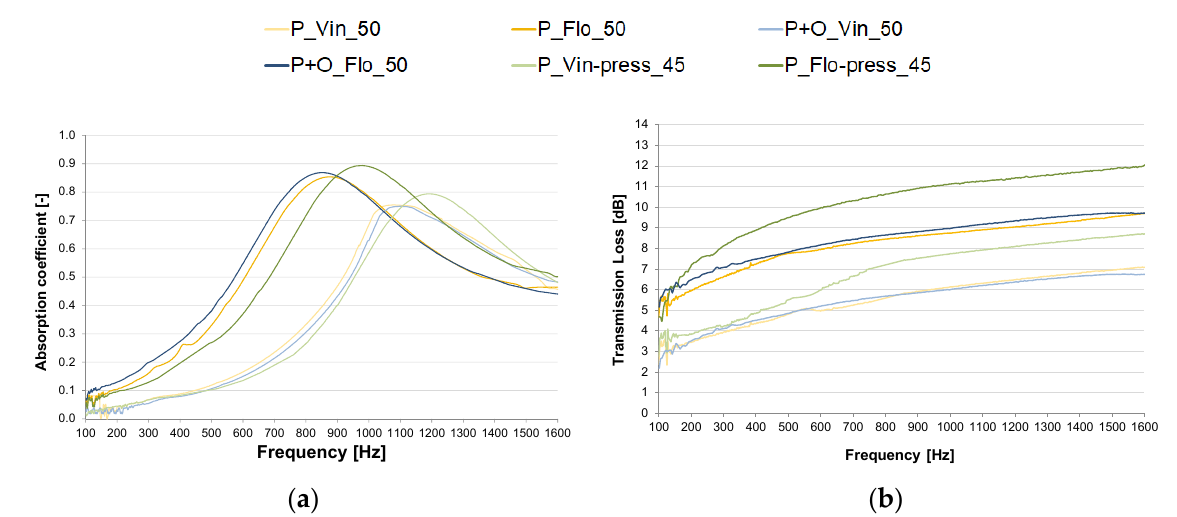
Figure 6. Influence of pressing technique on the acoustic performance of pine panels: ( a ) sound absorption coefficient and ( b ) Transmission loss at normal incidence.